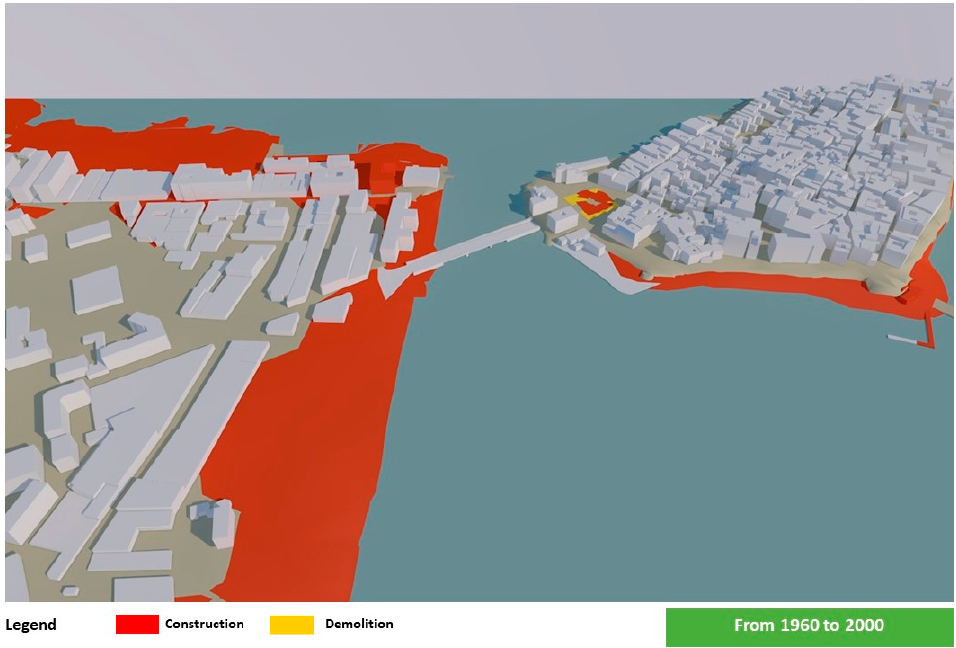
Figure A6. Three-dimensional model of differences between volumes built or demolished—from 1960 to 2000.